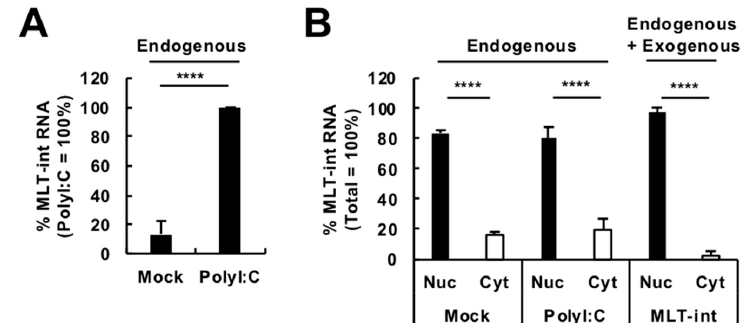
Figure 3. Expression of MLT-int-containing transcripts in cultured cells. ( A ) Induction of MLT-int RNA by a polyI:C treatment. ( B ) Subcellular localization of MLT-int RNA in Mock, polyI:C-treated, and MLT-int-expressing 293T cells. The values are expressed as the mean ± standard error (SE) of at least four independent experiments; **** p < 0.001.